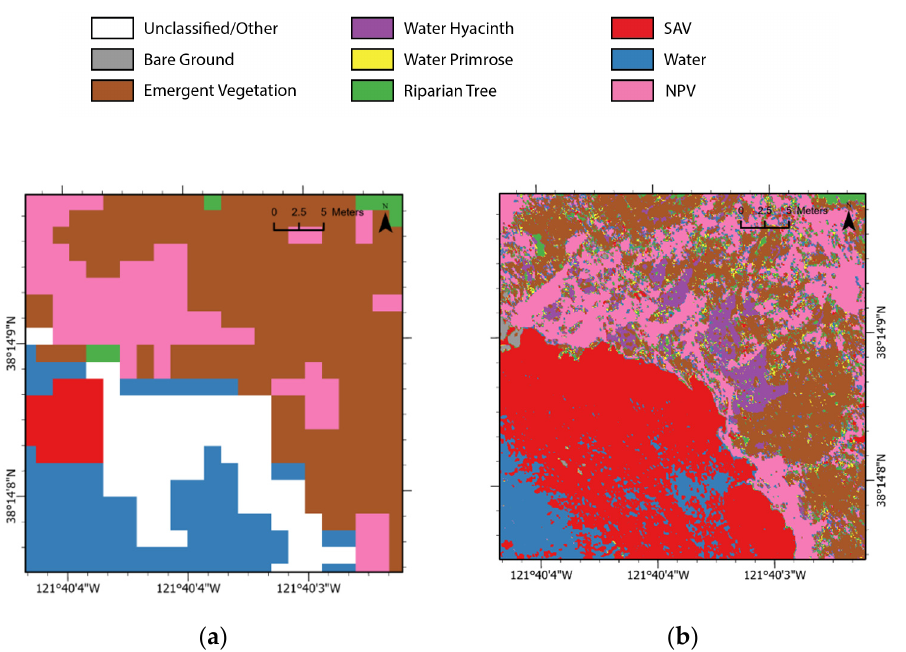
Figure 10. Close-up of the location with the most water hyacinth present. ( a ) HyMap map; ( b ) Nano map, showing the improved spatial detail as well as some class